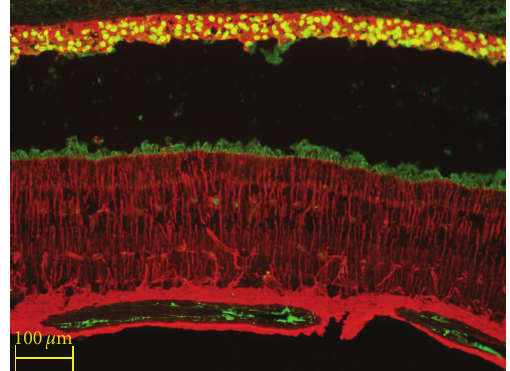
Figure 4: Xenografted hNPCs incorporated into the porcine RPE monolayer. Donor cells are labeled with anti-human nuclear label (upper left, yellow-green). In this case, a single donor profile is seen within the subretinal space, and the remainder are located at the level of the retinal pigment epithelium (RPE), labeled here with anticytokeratin (red). The human donor cells occupy a region corresponding to a focal discontinuity in the cytokeratin labeling. Survival = 10